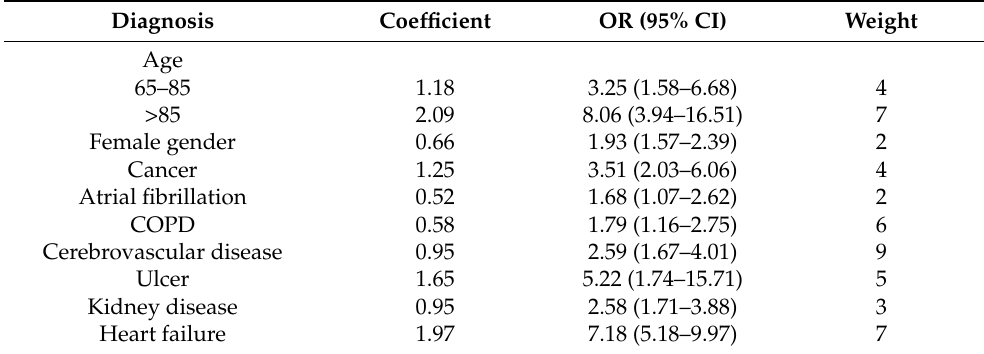
Table 2. Assignment of weights in the development of PRIMOF score through multivariable logistic regression.